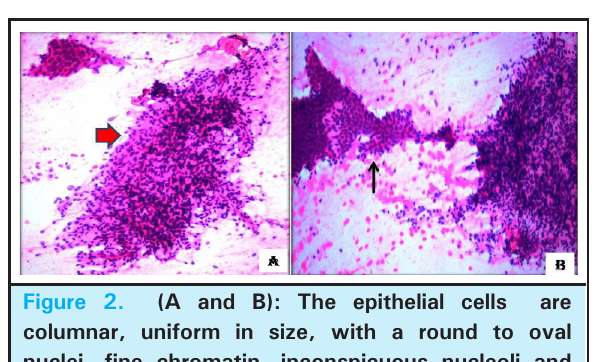
Figure 2. (A and B): The epithelial cells are columnar, uniform in size, with a round to oval